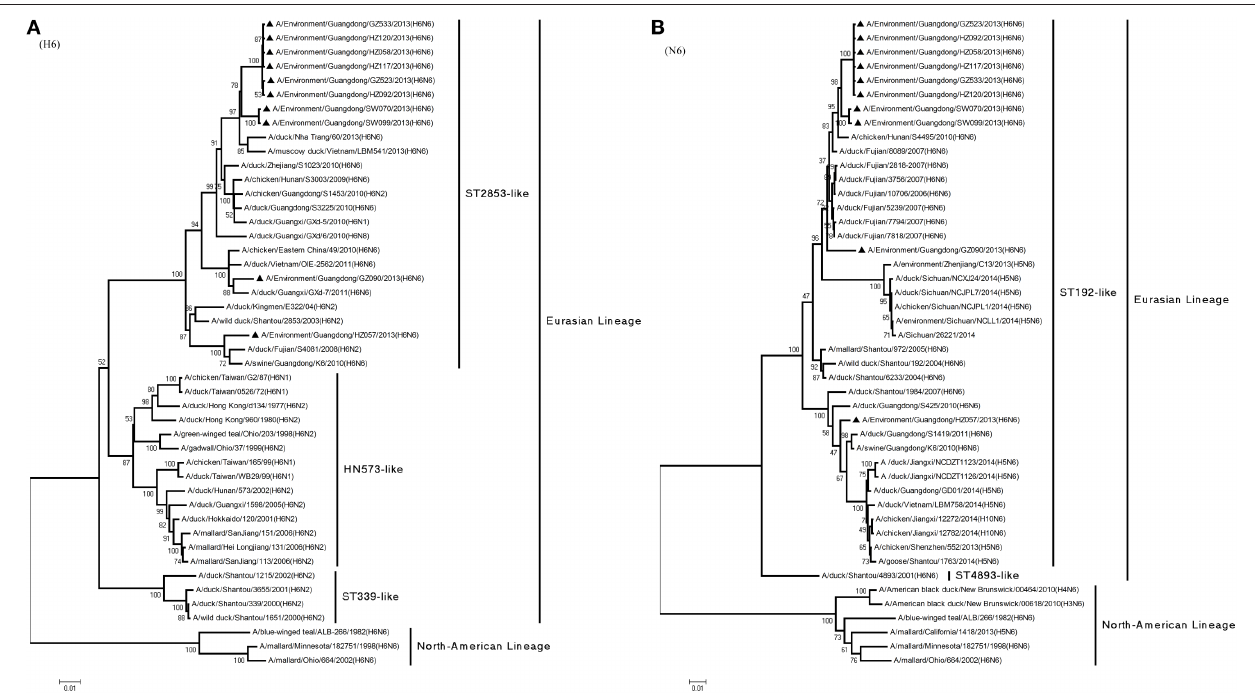
FIGURE 2 | Phylogenetic trees of the open reading frame of hemagglutinin (A) and neuraminidase (B) genes of subtype H6N6 influenza viruses isolated in Guangdong. Viruses indicated with black triangles ( N ) were characterized in this study. The trees were constructed using the neighbor-joining method of MEGA 6.06, with 1000 bootstrap trials to assign confidence to the groupings.